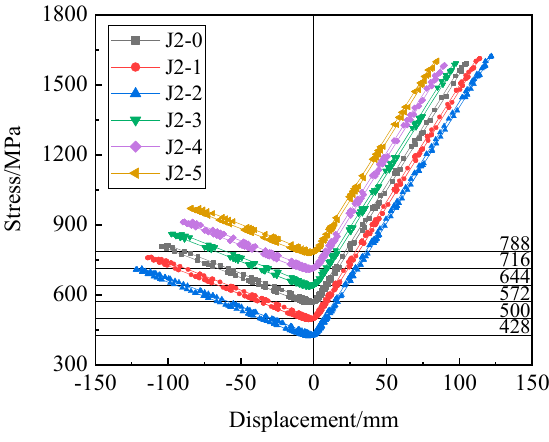
Figure 22. Stress variation curves of steel strands.